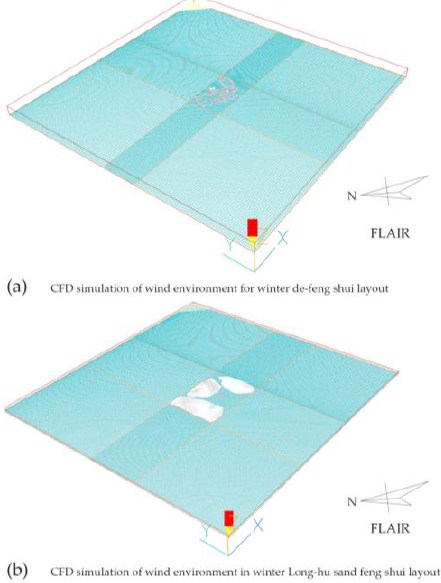
Figure 8. CFD mesh settings: ( a ) the non-Feng Shui layout; ( b ) the Feng Shui layout.